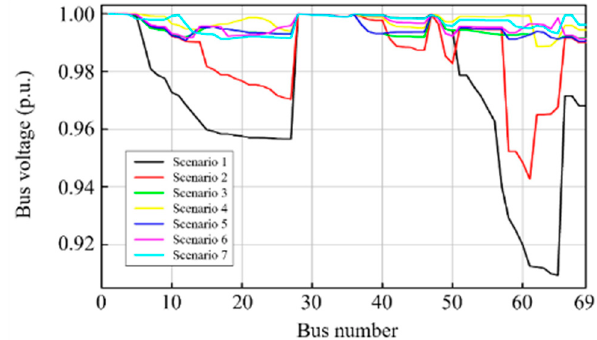
Figure 6. A comparison of bus voltage profile of 69-bus system for seven scenarios performed by proposed ASFLA.